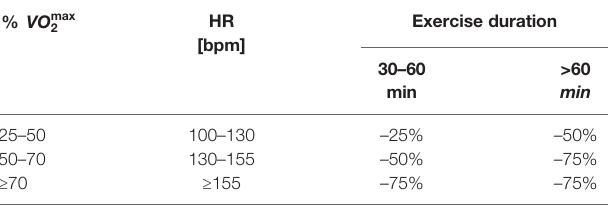
TABLE 2 | Consensus guidelines: recommended bolus insulin reduction for pre- exercise meal if bolus is administered within 120 min of exercise onset.